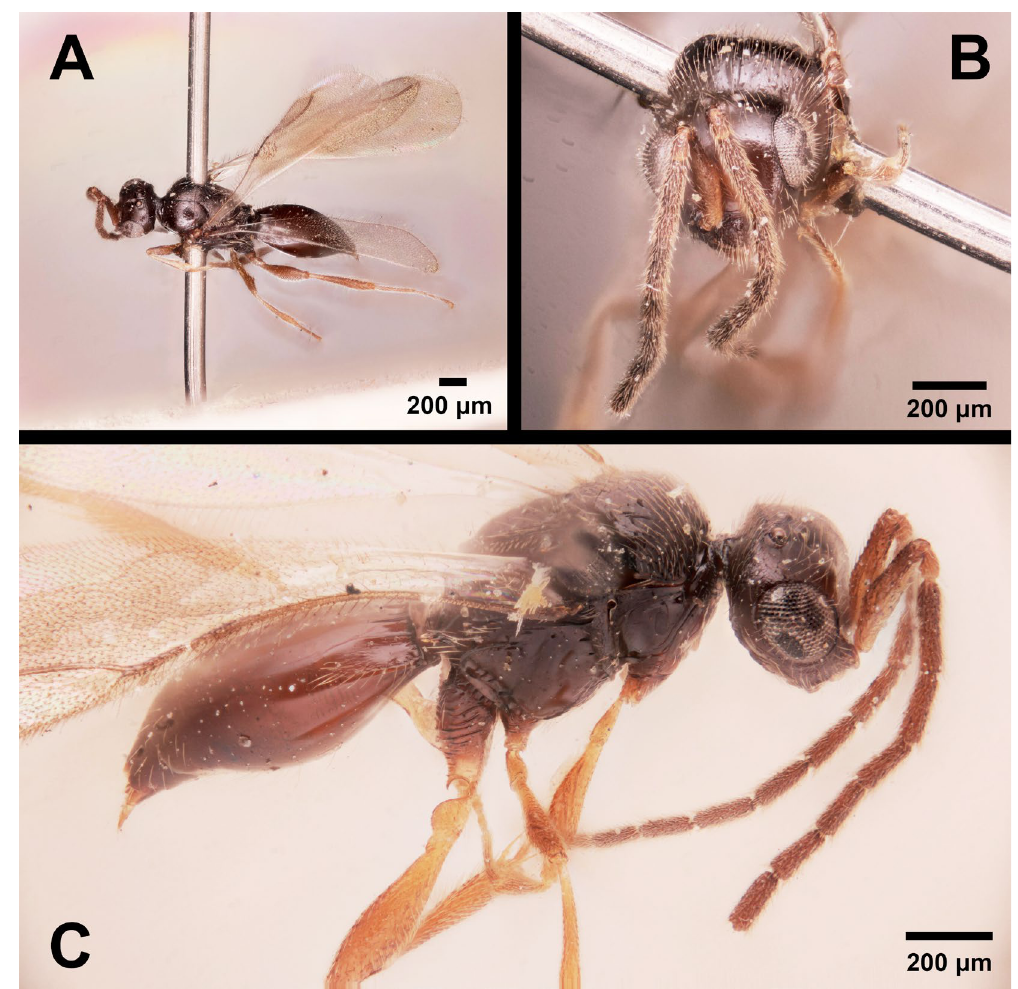
Fig. 11. Ceraphron cavifrons risbec, 1950, holotype, ♂ (MNhN EY22473). A . Dorsal view. B . Frontal view. C. Lateral